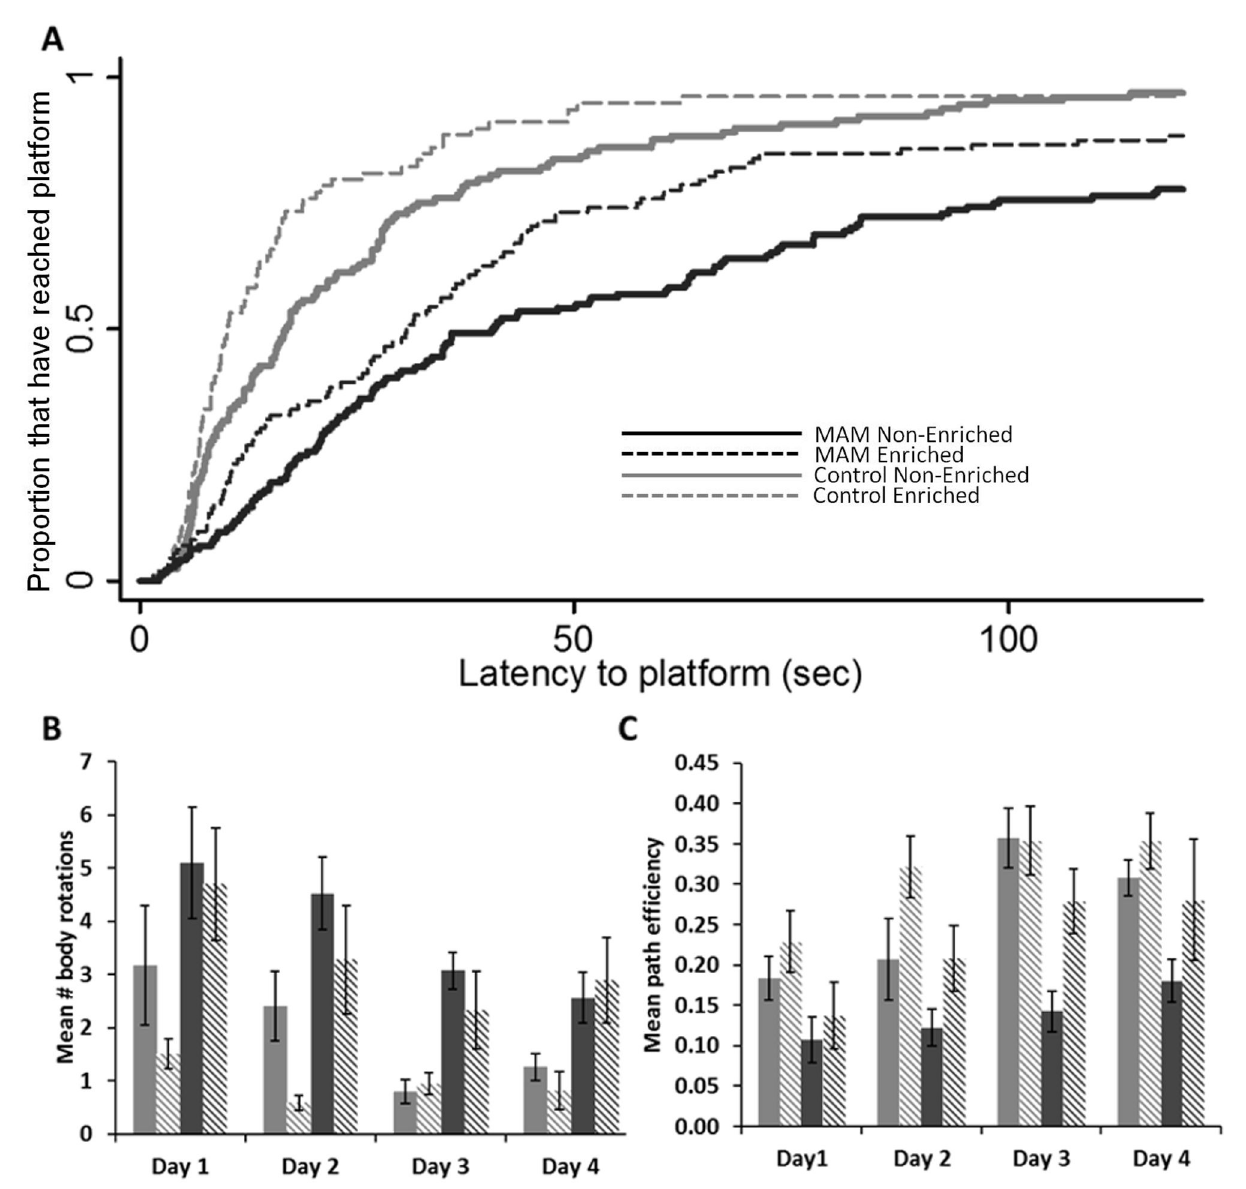
Figure 2. Morris water maze performance data for control and MAM treated rats. ( A ) Survival analysis representing the fraction of animals that have found the platform during a trial, capped a 120 seconds. The effect of day has been modeled in. The solid black line represents MAM non-enriched, the dotted black line represents MAM enriched, the solid grey line represents control non-enriched, and the dotted grey line represents control enriched. Controls were shown to outperform MAM animals (p<0.001), and enriched animals outperformed their non-enriched counterparts (p<0.026). ( B ) Mean number of body rotations, averaged per day. Higher numbers of rotations indicate less certainty in the where the platform is located. The solid grey bar is control non- enriched, the diagonally segmented grey bar is control enriched, the black solid bar is MAM non-enriched and the diagonally segmented black bar is MAM enriched. Controls had fewer body rotations than MAM (p<0.001), and enriched animals had fewer rotations than non-enriched (p<0.024). ( C ) Mean path efficiency per day. Path efficiency indicated the directness of the animal’s path to the platform, higher values representing a more direct path. Controls outperformed MAM (p<0.001), and enriched animals outperformed non-enriched (p<0.007).